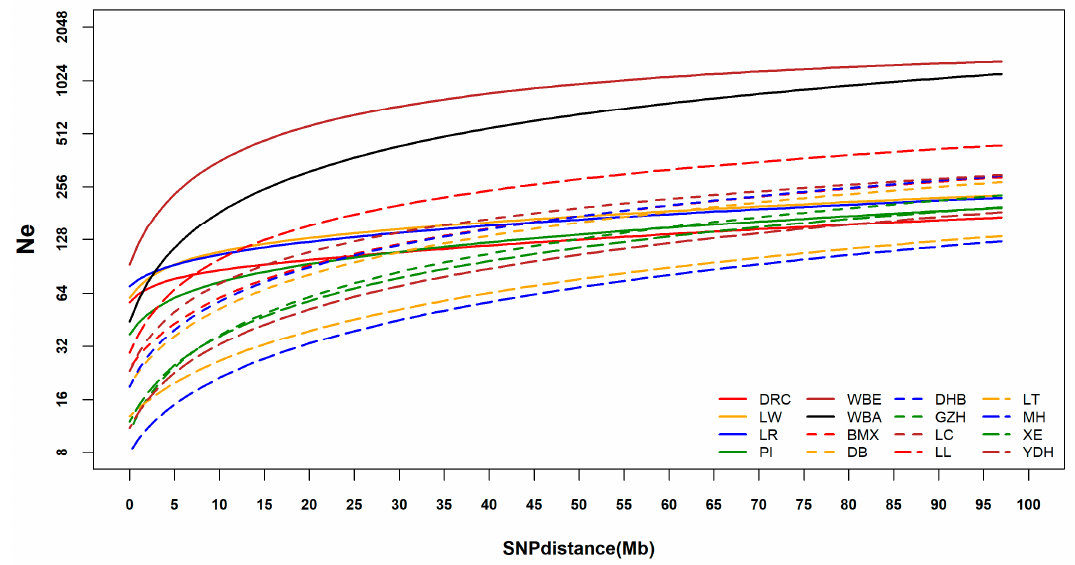
Figure 6. Historical effective population size (Ne) of each breed 1 . 1 DR = Duroc; LW = Large White; LR = Landrace; PI = Pietrain; WBE = European wild boar; WBA = Asian wild boar; BMX = Bamaxiang; DB = Debao; DHB = Dahuabai; GZH = Guizhonghua; LC = Luchuan; LL = Longlin; LT = Lantang; MH = Meihua; XE = Guangdongxiaohua; YDH = Yuedonghei.